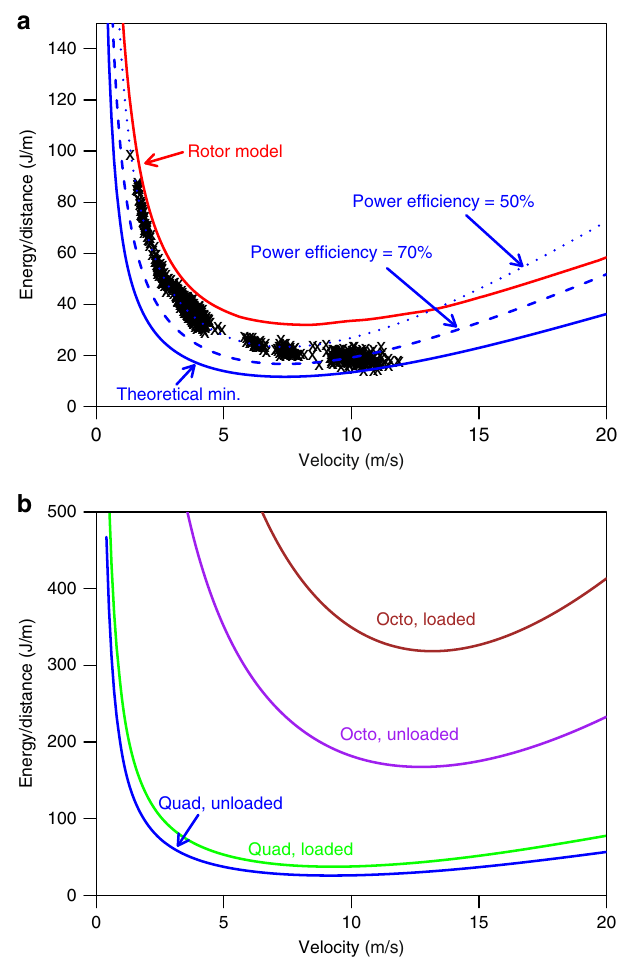
Fig. 1 Energy use of a drone per distance traveled at various velocities. a Comparison of measured data with several models for the unloaded quadcopter. The theoretical minimum (theoretical min.), represented by the solid blue line, is calculated by Eqs. 6 and 7. The dashed blue line shows the power ef fi ciency curve at 70% and the dotted blue line the power ef fi ciency at 50%. These are calculated by Eq. 8 with the values of η (power ef fi ciency) noted. The red line shows results incorporating the manufacturer-supplied rotor properties (see Methods for rotor model). Black crosses denote measured data for 1073 fl ight segments. b Base-case model results for quadcopter (Quad) and octocopter (Octo), with